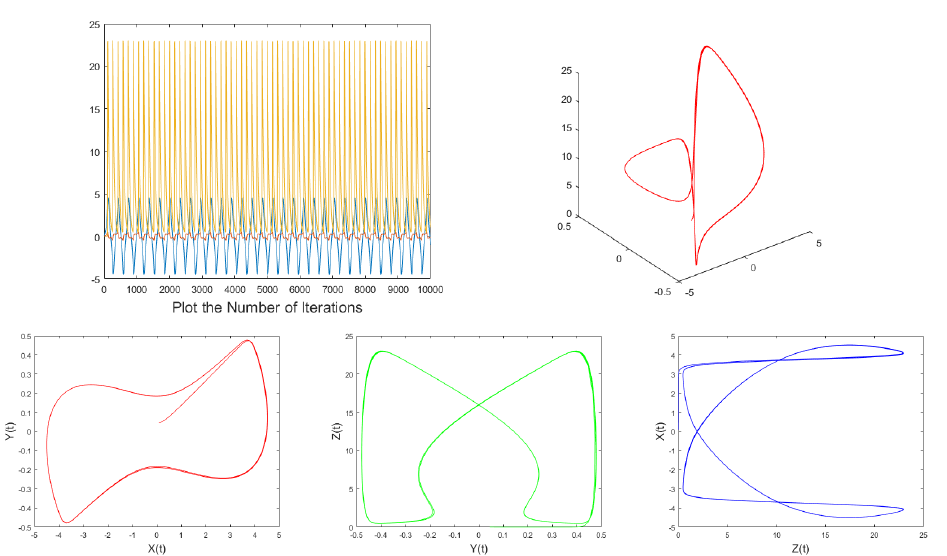
Fig. 6 Unstable trajectories (limit cycle) which are away from the origin in the system D 9 , 7 , 54 [ 16 ] . 1.2 Stability of the Fixed Point ( The Jacobian about the equilibrium point ( −